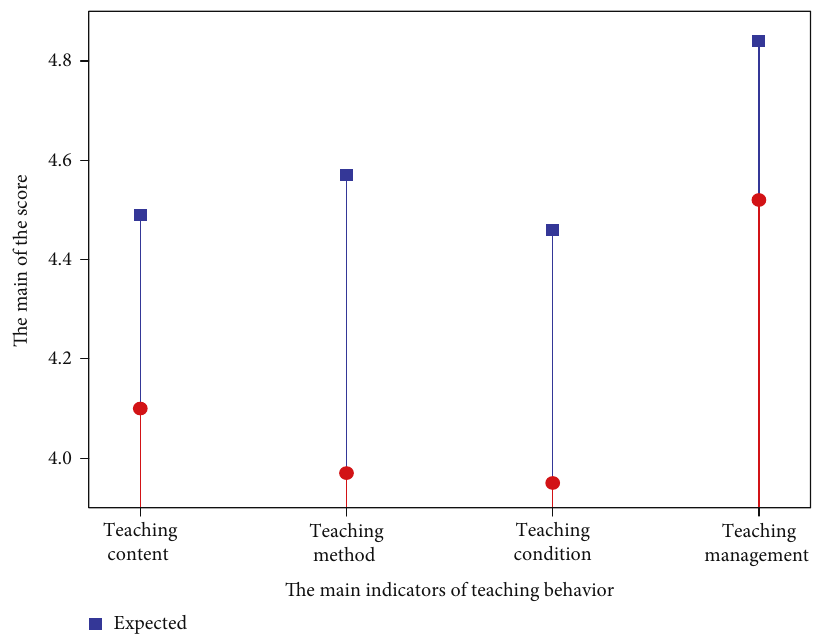
Figure 5: The score comparison between actual teaching behaviors and expected.